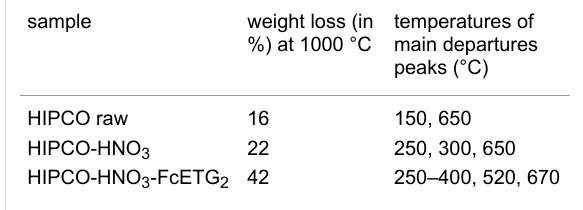
Table 2: Percentages of weight loss and temperature of the main de- sorption peaks measured in TGA-MS for raw, oxidized and functionali- zed HIPCO